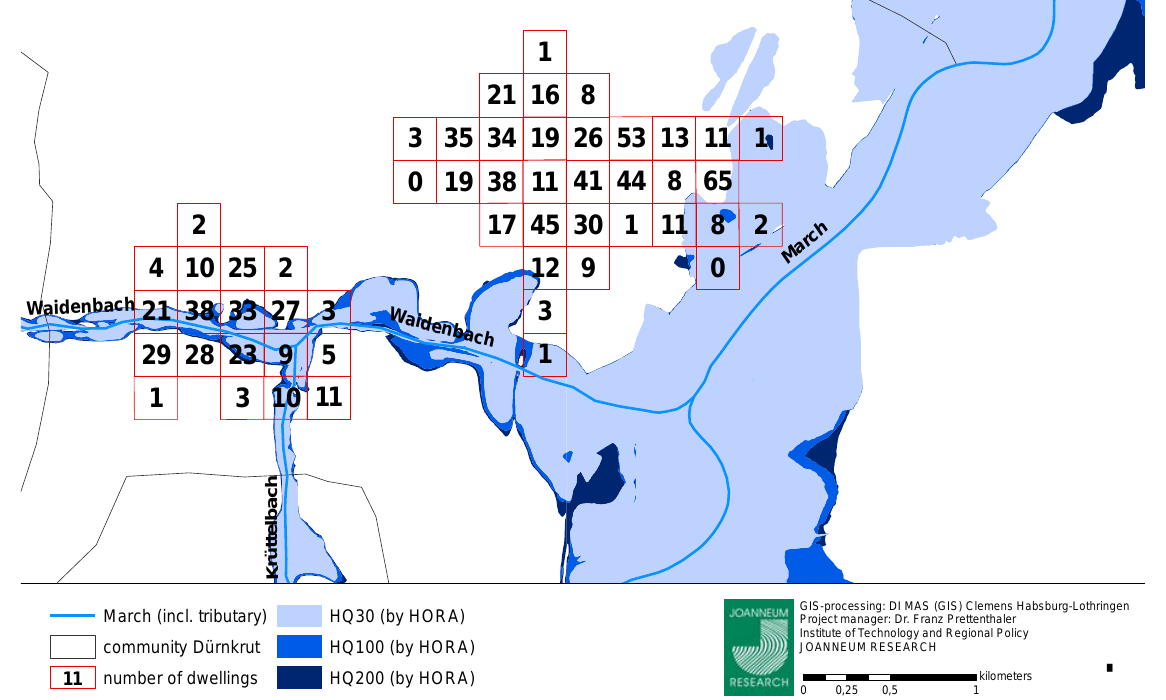
Figure 1. Spatial distribution of residential apartments in the HQ30, the HQ100 and the HQ200 risk zones. Data source: Statistics Austria, Wohnungs- und Gebäudezählung, 2001, and HORA – Hochwasserrisikozonierungssystem Austria.